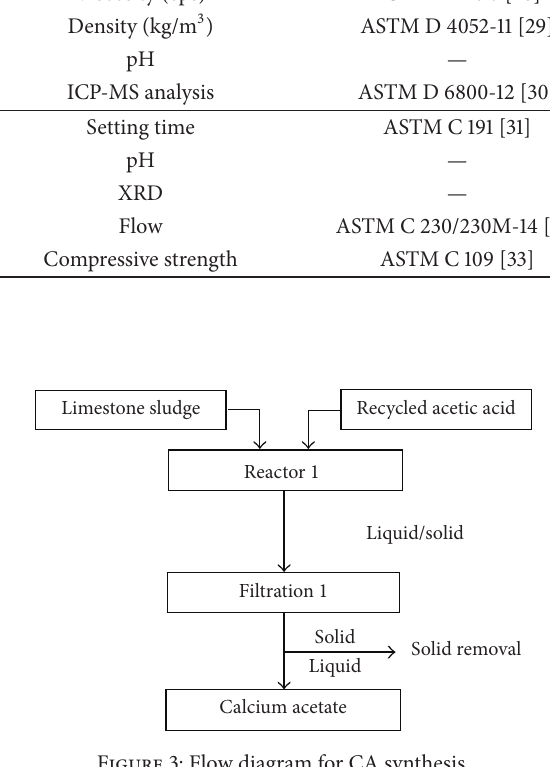
Figure 3: Flow diagram for CA